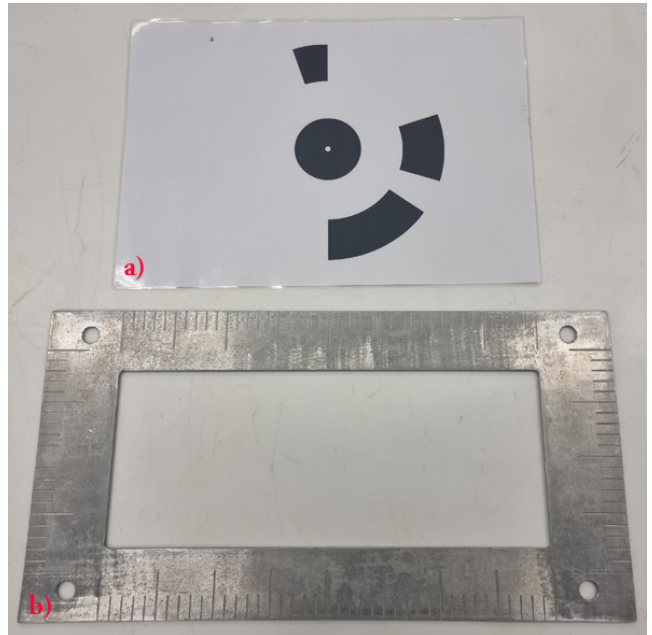
Figure 6. ( a ) Classical black and white target and ( b ) aluminum target with scale and predefined wholes at the corners for the GNSS measurements in the shallow water.